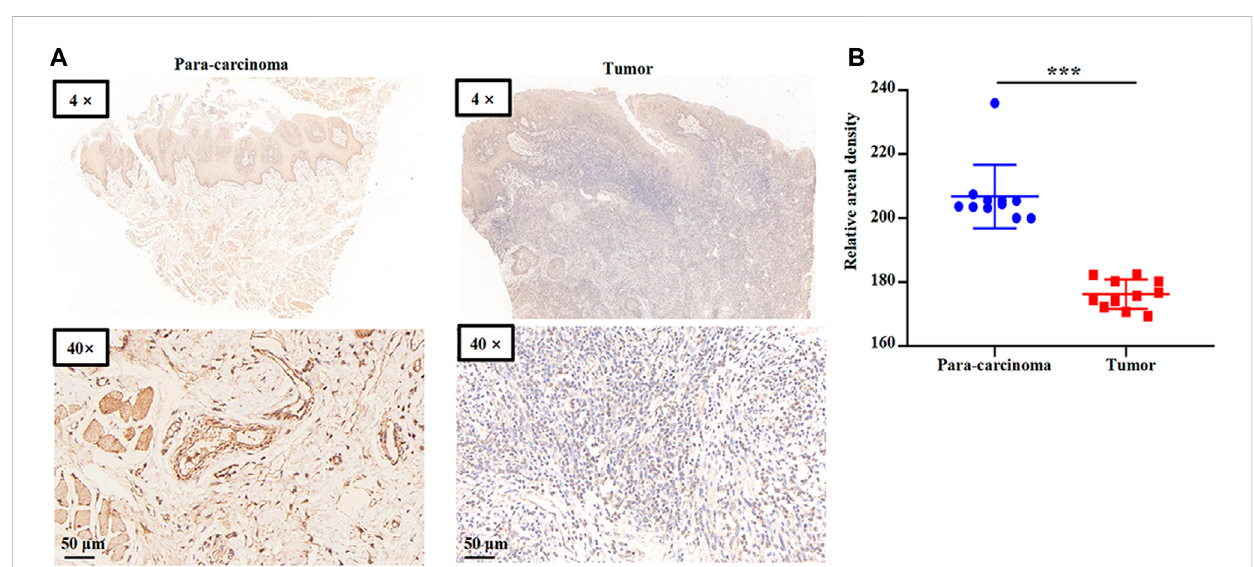
FIGURE 4 RepresentativeimmunohistochemicalstainingforGSTK1proteininHNSC (A) ImmunohistochemicalstainingofGSTK1wasperformedintumor( n = 11) and para-carcinoma tissues ( n = 11). Representative images are shown. Score bars, 50 μ m. (B) Staining was quanti fi ed as shown. The dot plot depicts the mean and standard deviation of 11 images of tumor and adjacent normal tissues. (*** p <